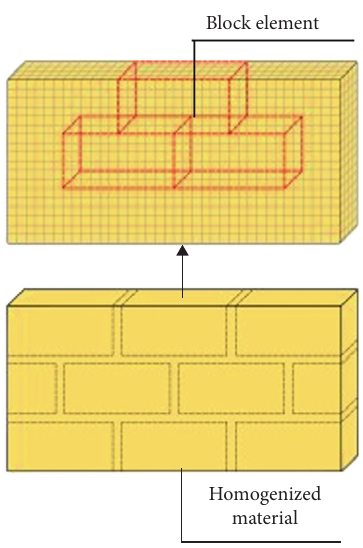
Figure 10: Homogeneous material